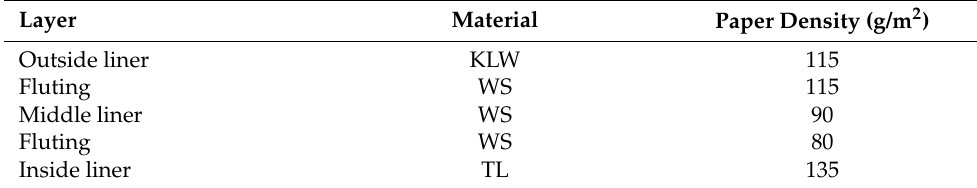
Table 3. Composition of the chosen